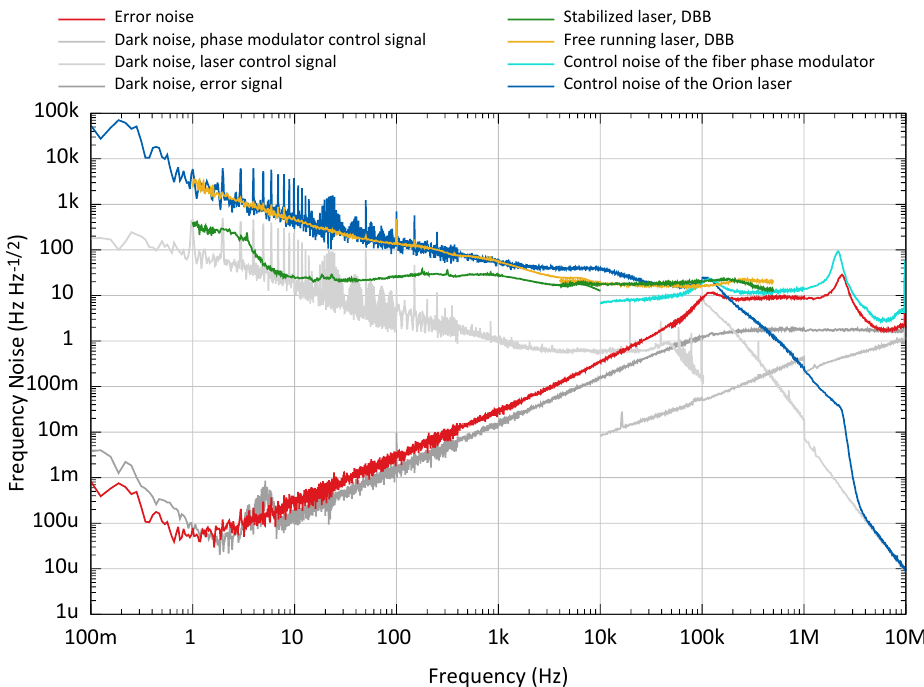
Figure 12. The calibrated control signal noise (blue) and the calibrated error signal noise (red) are plotted for the frequency stabilization.